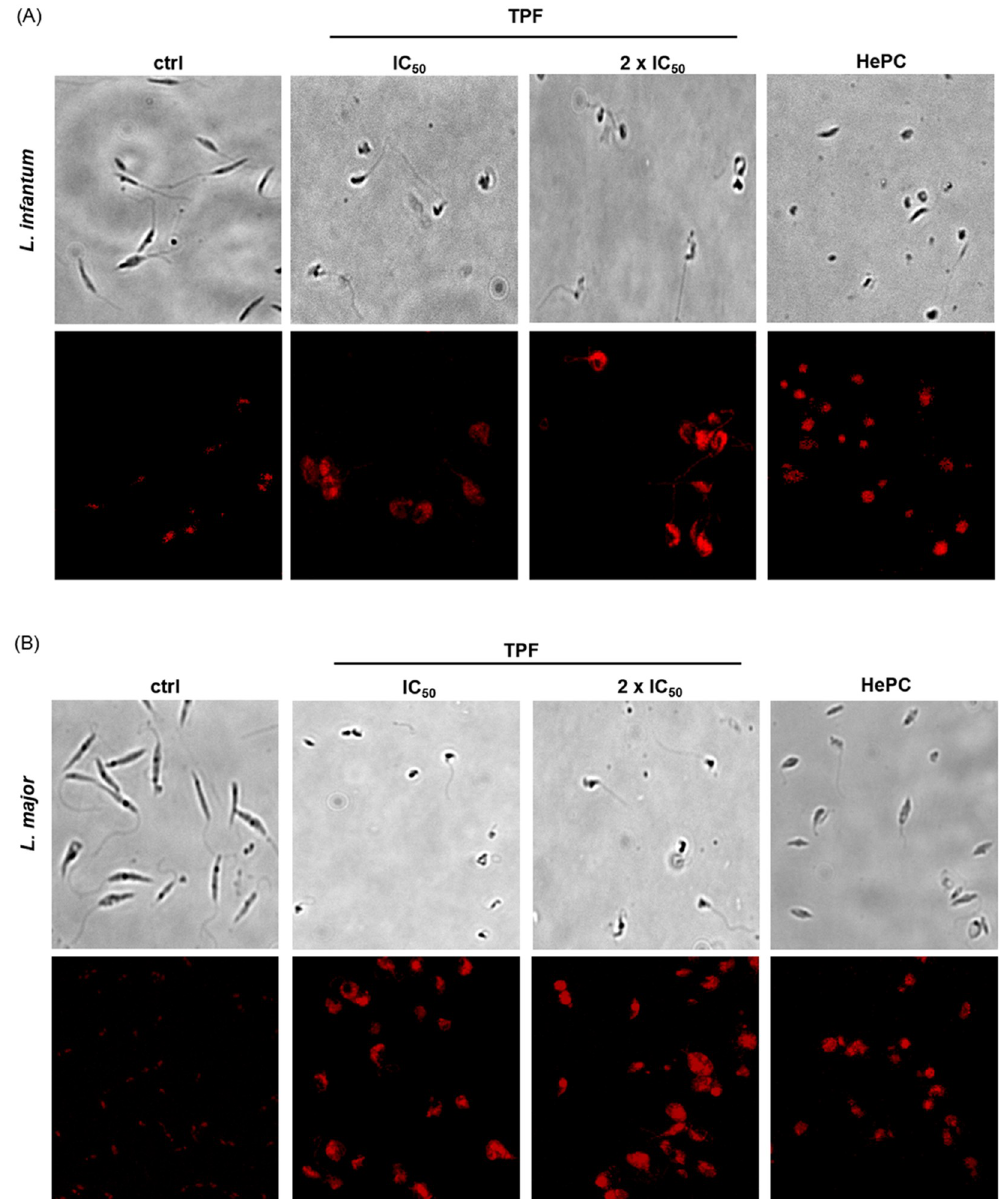
Fig 4. Microscopy images of Leishmania spp. promastigotes. significant lower percentages of cells detected in the G1 peak region, compared with untreated parasites. Untreated L . infantum and L . major parasites had 74% and 59% of cells at G1 phase, respectively, at 24 h, while the relevant percentages of L . infantum promastigotes were 21% and 47% after treatment with IC and 2 x IC concentrations of TPF (Fig 5A and 5C). 50 50 Accordingly, the percentages of L . major promastigotes in G1 peak region after exposure to both TPF concentrations, were 10% and 23%, respectively (Fig 5B and 5D). Moreover, after 48 and 72 h of treatment, the proportions of TPF-treated promastigotes in the G1 region were